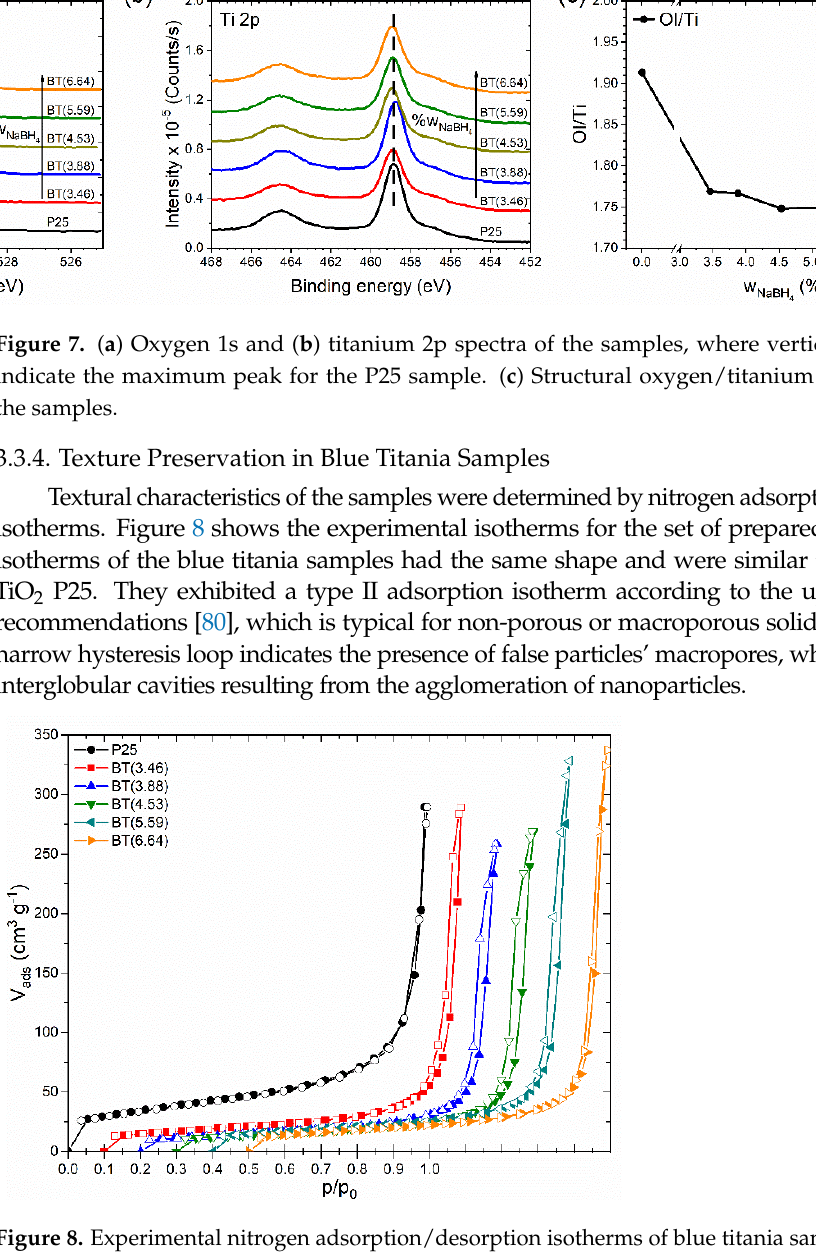
Figure 7. ( a ) Oxygen 1s and ( b ) titanium 2p spectra of the samples, where vertical dashed lines indicate the maximum peak for the P25 sample. ( c ) Structural oxygen/titanium ratio (OI/Ti) of the samples.